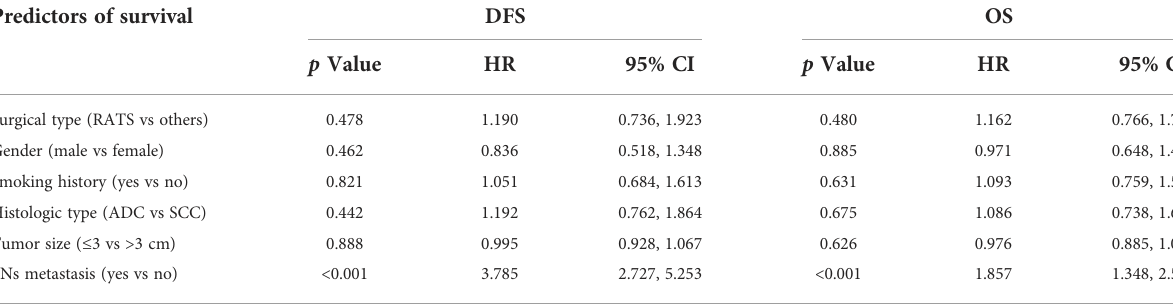
TABLE 5 Cox ’ s proportional hazards regression model analysis for survival pro fi les of matched populations. Predictors of